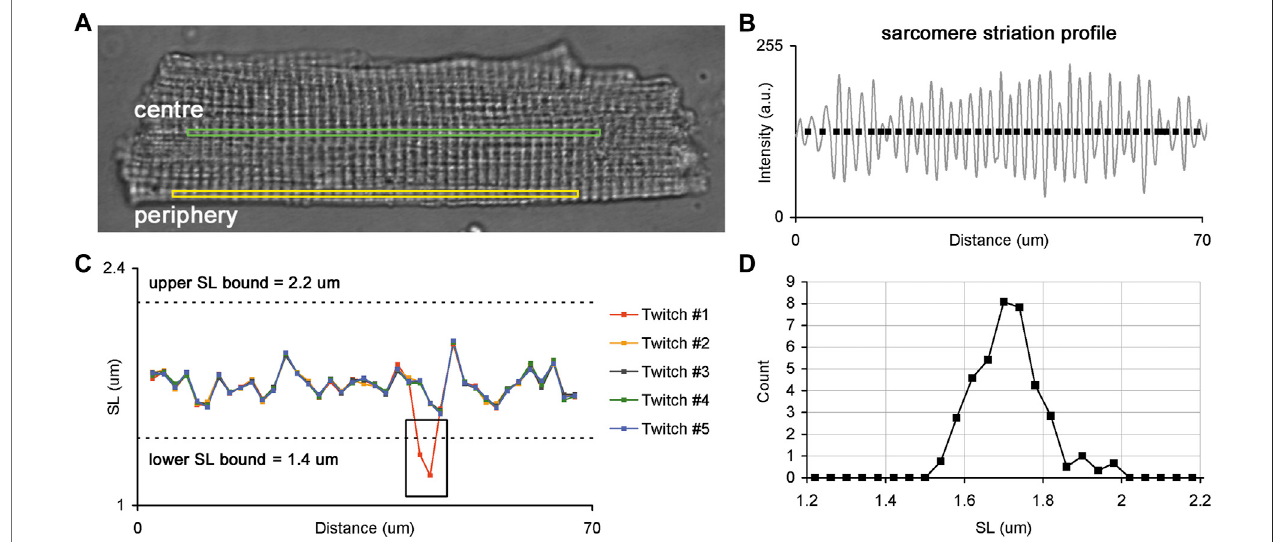
FIGURE 1 | Sarcomere striation pro fi le in a single isolated membrane intact guinea-pig cardiomyocyte. (A) Whole-cell image of a single cardiomyocyte with two ROIs selected for the analysis of sarcomere striation pro fi les in two different regions: central (green) and peripheral (yellow) regions of the same cell. (B) Example of the sarcomere striation pro fi le observed in one ROI and one frame. The grey curve follows the sarcomere striation pro fi le, and black rectangles show the positions of individualsarcomeresalongtheROIbeginningfromtheleftedge. (C) PlotsofindividualSLvalues(here — end-diastolic)asafunctionoftheirpositionalongtheROI. The SLvalues ofeach cardiomyocyte werederived fromcorrespondingframesforend-diastole orend-systole, where severalconsecutive twitches weresuperimposed to obtain the SL values. The black box demonstrates where an error of SL measurement occurred because of the instability in the sarcomere detection in some frames. Such fragments were excluded from further analysis. Dashed lines show lower and upper SL bounds (1.4 and 2.2 µm for end-diastolic SL values, respectively). (D) SL distribution obtained from data displayed in “ C ” . See text for more details.